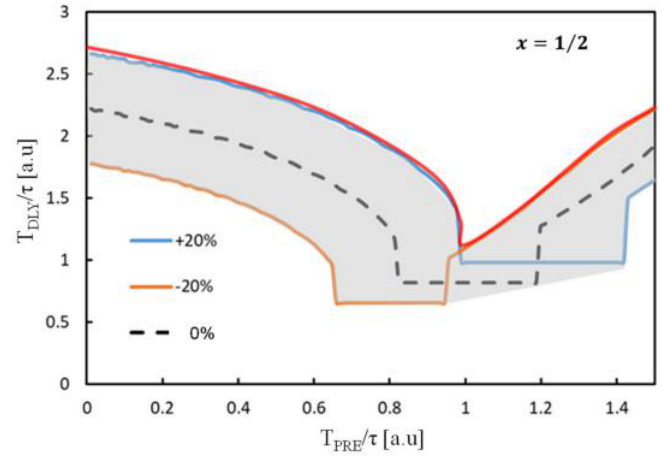
Figure 8. T DLY as a function of T PRE under the worst corner.